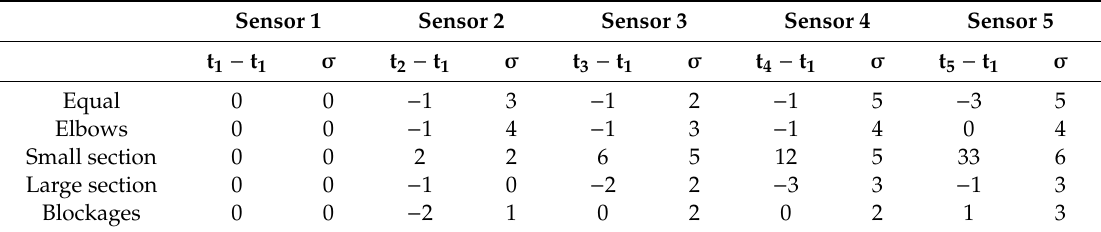
Table 4. Average of time delays (s) in the pressure transmission with respect to the first sensor for the 3 velocities used and standard deviations.